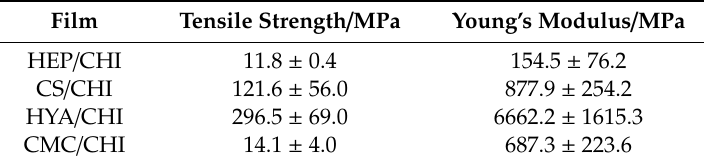
Table 4. Mechanical strength and Young’s modulus of polysaccharide composite films.